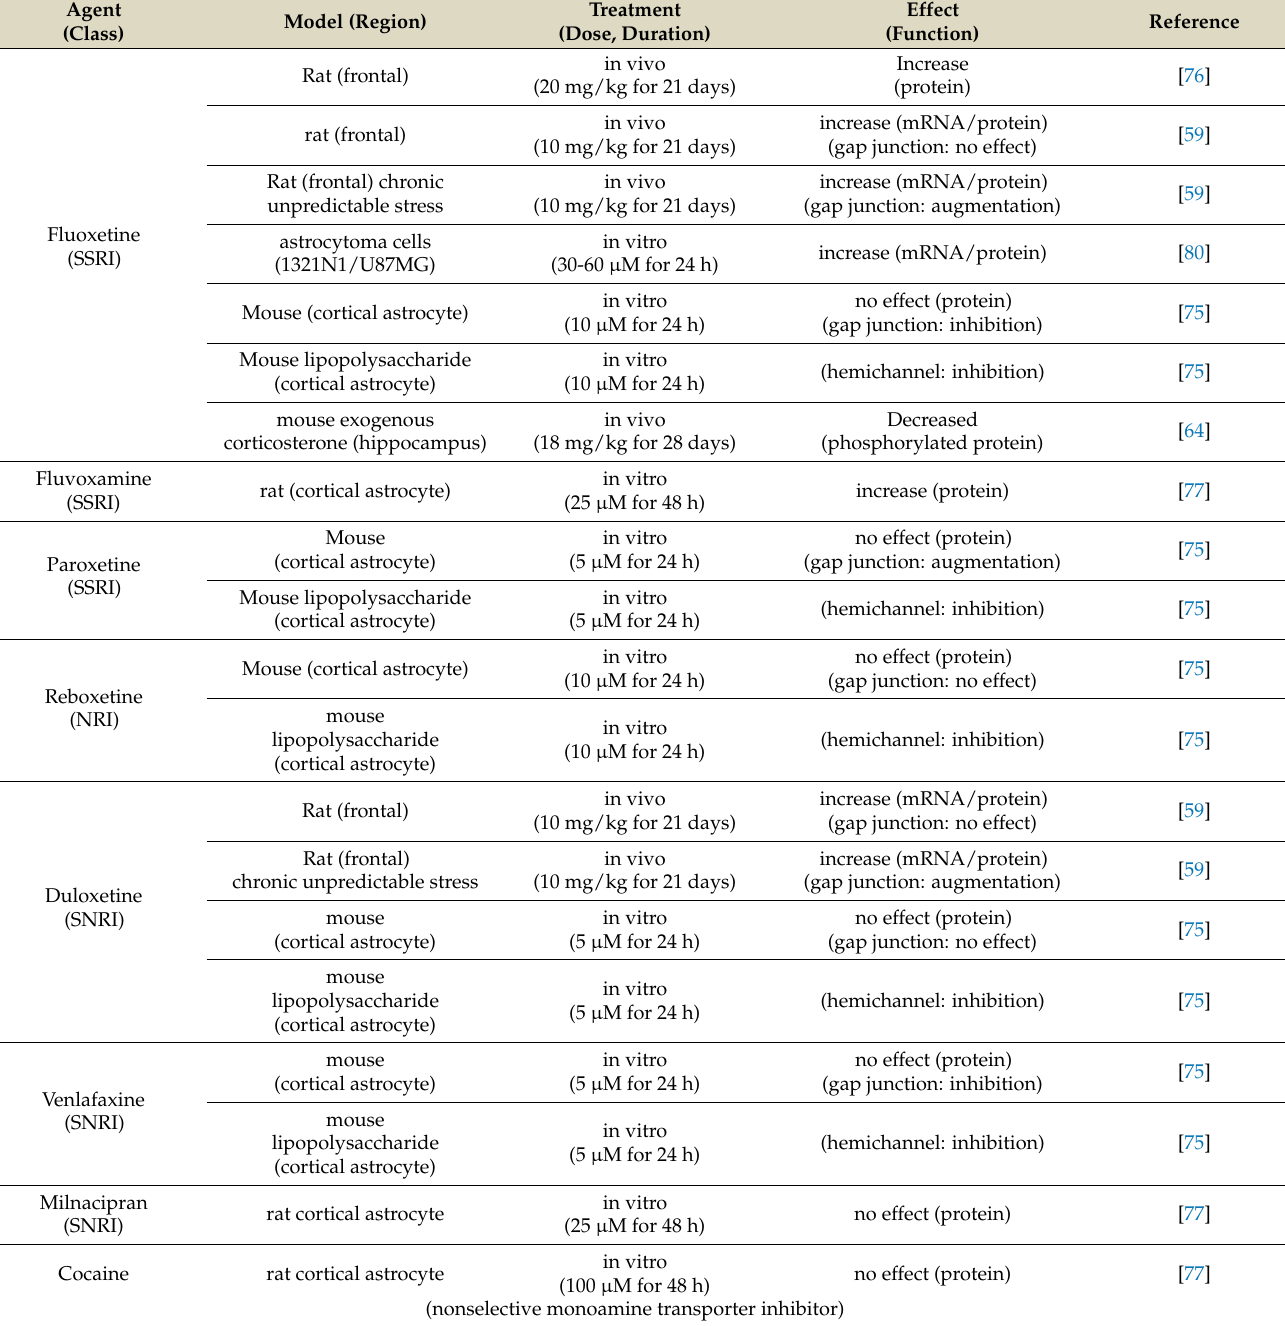
We searched MEDLINE using the keywords “(((connexin) OR (hemichannel) OR (gap junction)) AND ((antidepressant) OR (psychotropic drugs)))” for papers published by 1 November 2020. Relevant articles were obtained in full and assessed for inclusion independently by reviewers. Disagreements among reviewers were resolved via discussion to reach a